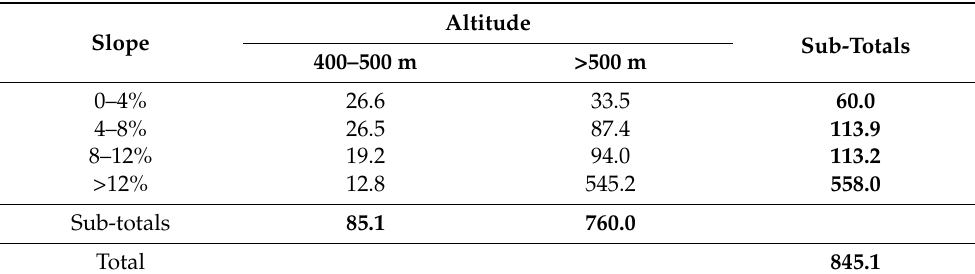
Table 1. Current chestnut areas (ha) by four slope intervals and two altitude classes and the respective percentages to sub-total and total